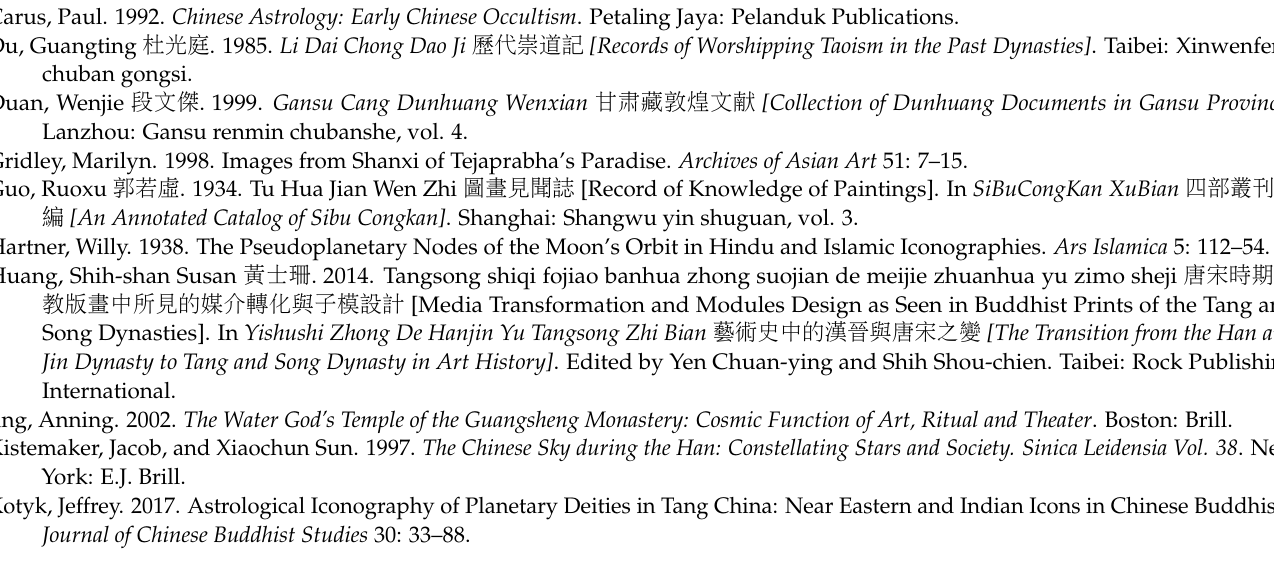
Figure 3. Tejaprabh ā procession, ca. 10th century, ink and colors on paper. 30.5 cm × 76.4 cm,